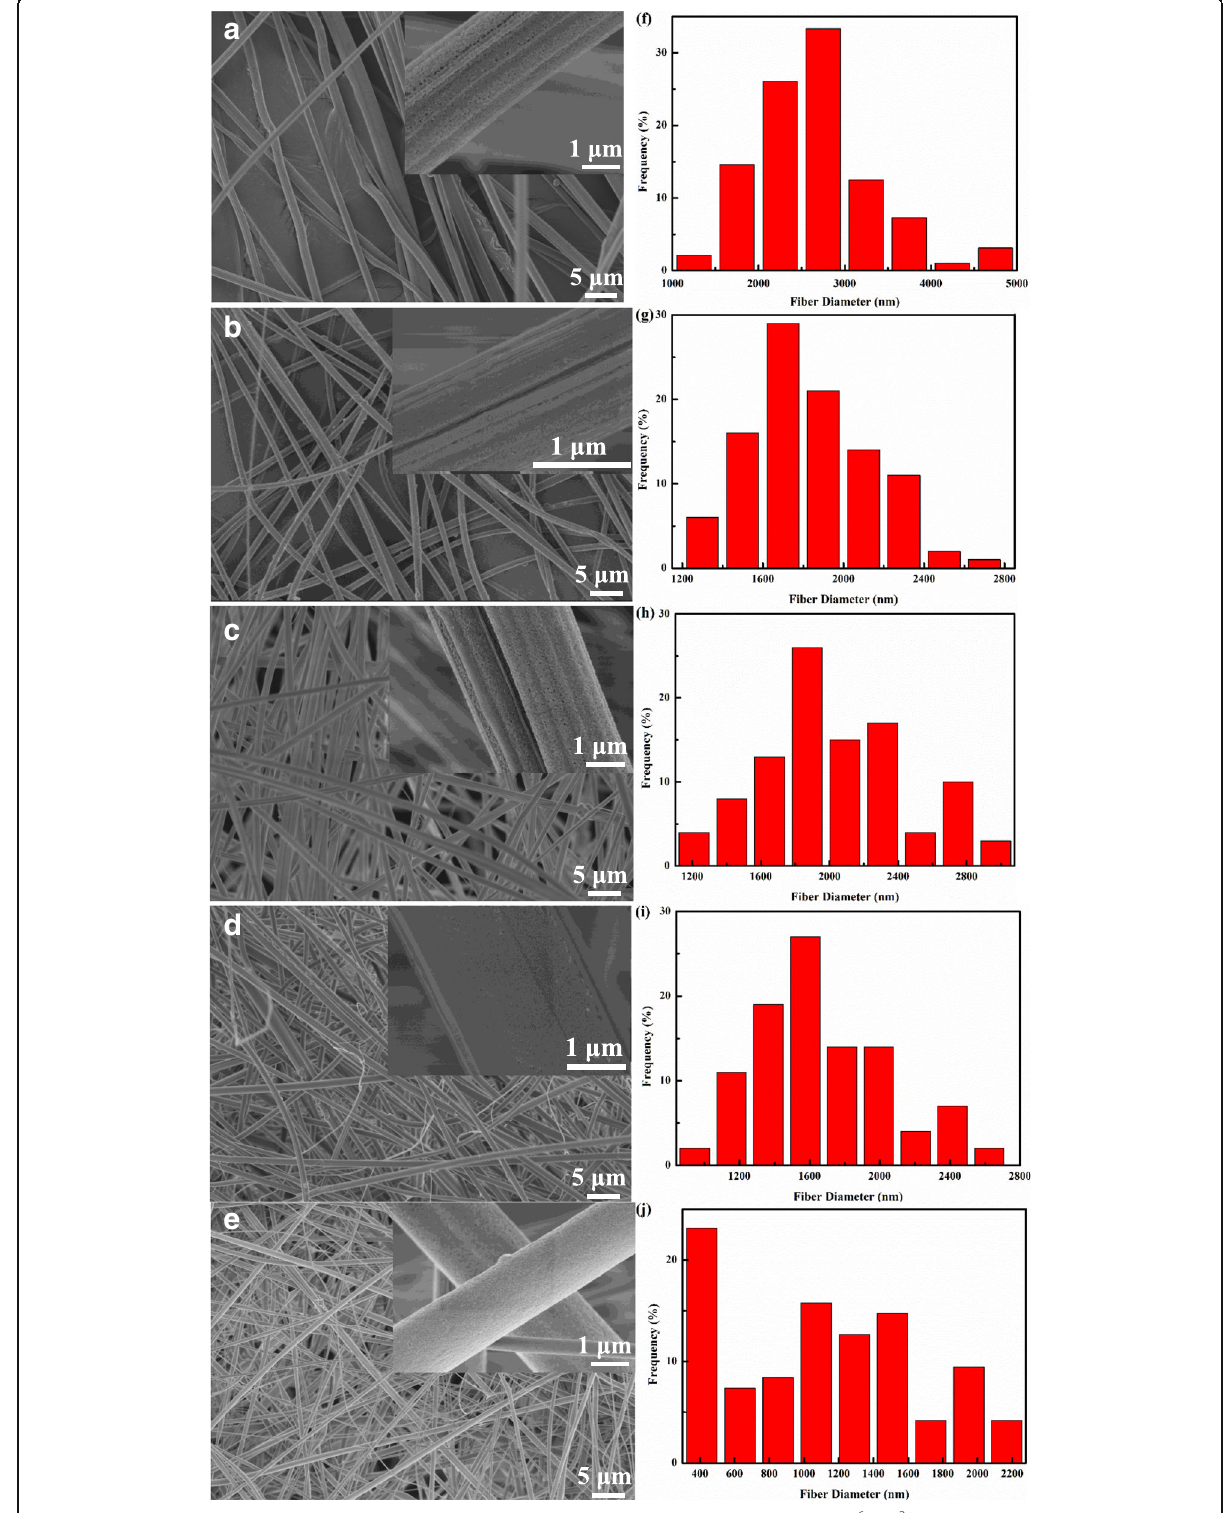
Fig. 3 FESEM pictures and fiber diameter distribution of micro-nanofibers with different molar ratio (W 6+ :Co 3+ ). a , f PAN/PS W 1 , b , g PAN/PS Co 1 , c , h PAN/PS W 1 Co 1 , d , i PAN/PS W 1 Co 2 , e , j PAN/PS W 1 Co